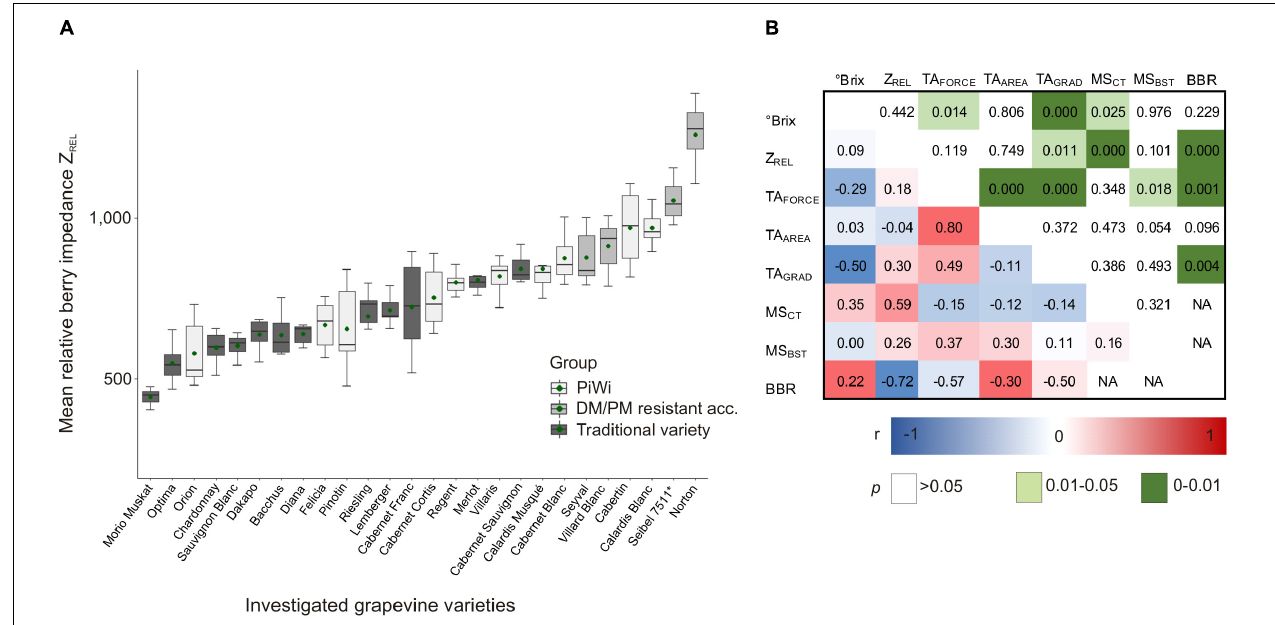
FIGURE 3 | Boxplot of relative berry impedance (Z REL ) of “traditional” (trad) and PiWi varieties (PiWi) as well as downy mildew- and powdery mildew-resistant grapevine accessions (A) and Pearson correlation of different berry skin traits and Botrytis bunch rot (B) . (A) N = 6 replicates per variety (i.e., 3 years as shown in Supplementary Table 1 , two replicates per year, and 15 berries per replicate); (B) N = 73 replicates ( N = 41 replicates for MS CT and MS BST ; N = 32 replicates for Botrytis bunch rot infection). PiWi, new resistant grapevine varieties; DM/PM, downy mildew/powdery mildew; acc., accession; ◦ Brix, berry sample sugar